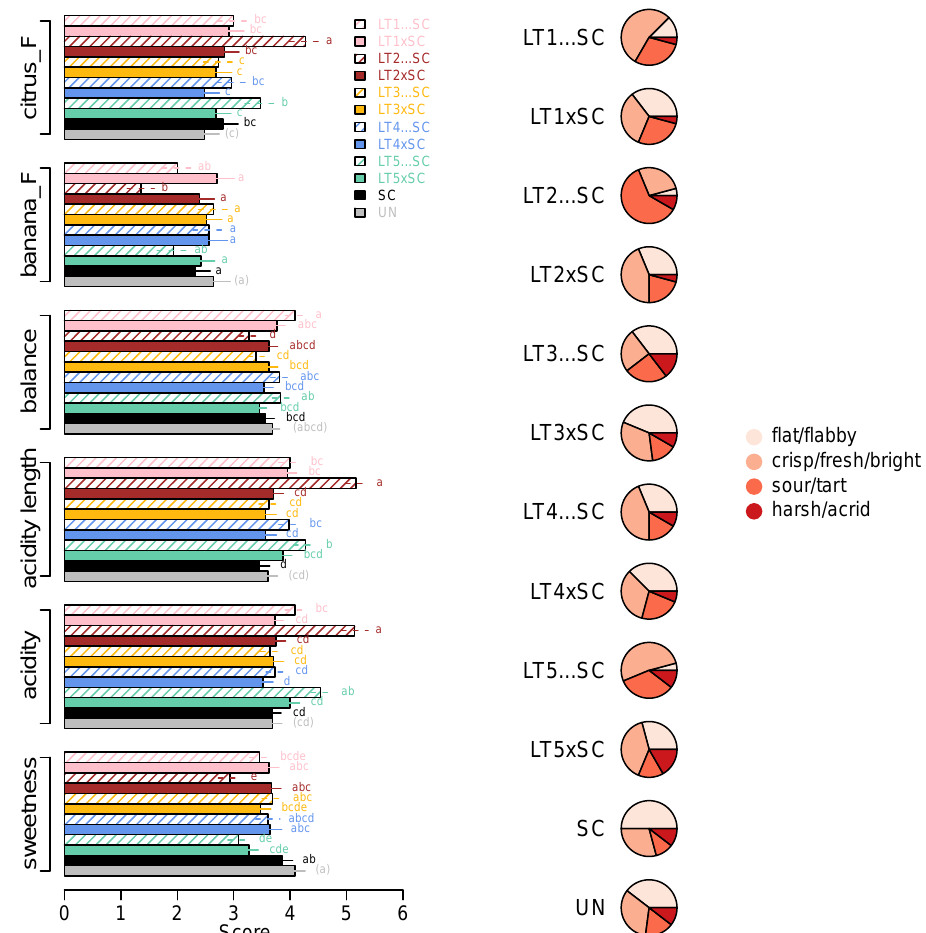
Figure 5. Intensity scores (means and standard errors) of sensory parameters significantly (ANOVA; Tukey’s post-hoc α = 5%; different letters represent significant differences) affected by yeast treatments ( left ) and acidity profiles of wines built with frequencies of four acidity descriptors ( right ; Table